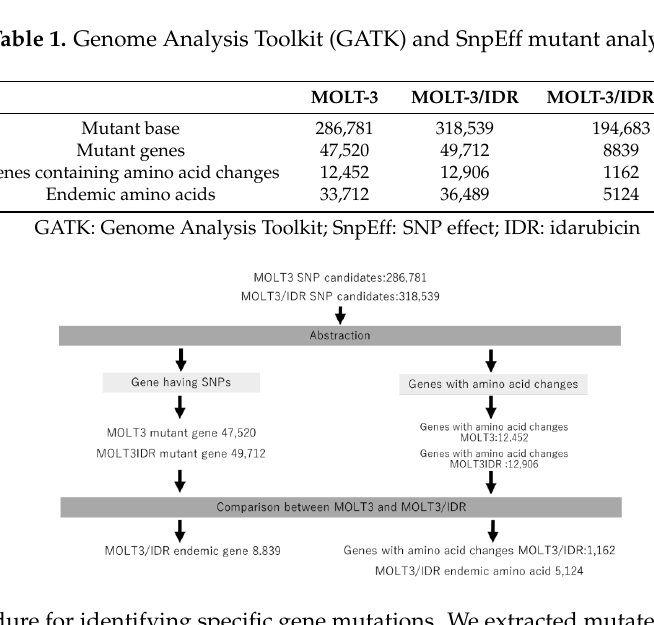
Table 2. Genes with polymerase-related amino acid changes.